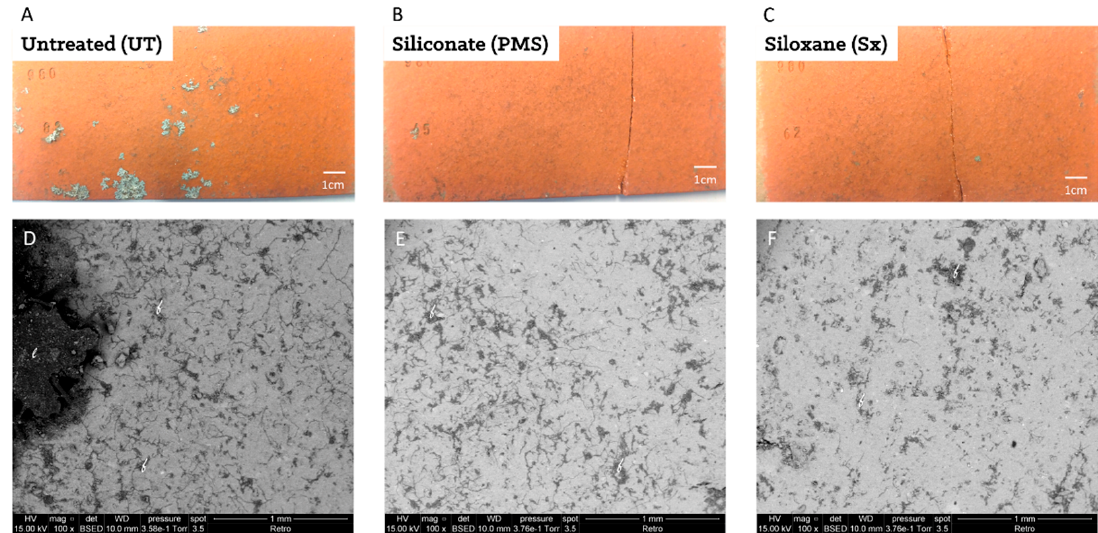
Figure 1. Macroscopic and backscattered SEM images of the biofilm colonizing tiles exposed 6 years: ( A – C ) 1 cm scale: ( A ) UT tile, ( B ) PMS tile, and ( C ) Sx tile. ( D – F ) 1 mm scale: ( D ) UT tile, ( E ) PMS tile, and ( F ) Sx tile. In the pictures, fungal filaments are represented by the letter f, and pioneer lichens by l.